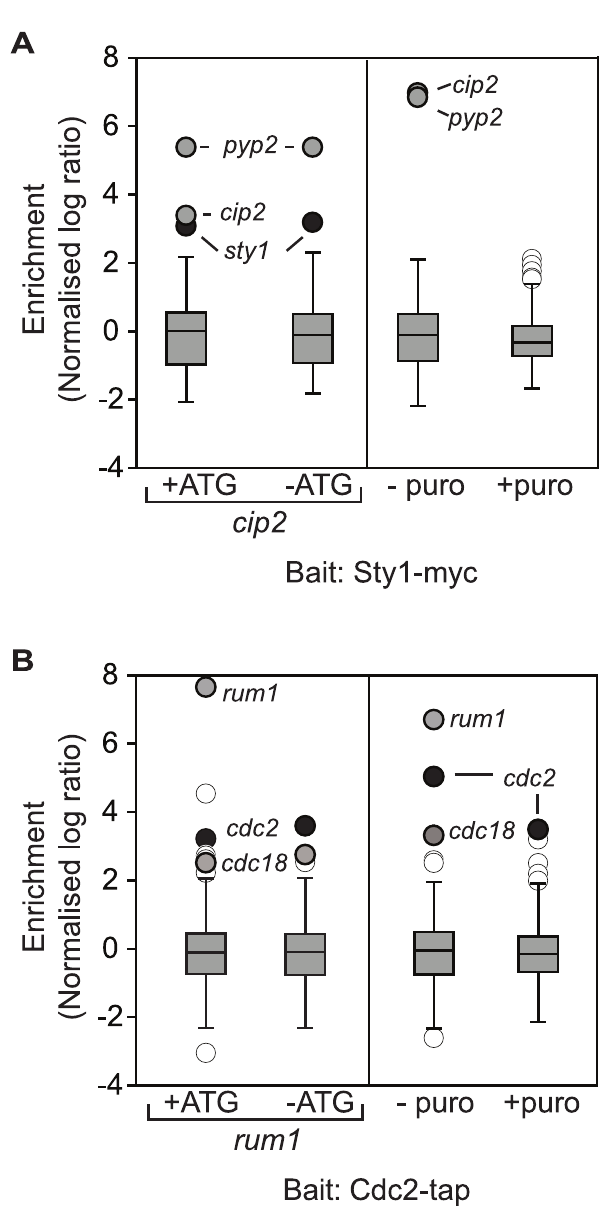
Figure 3. Cotranslational association of Cdc2p-Rum1p and Sty1p-Cip2p. Box plots of the distribution of normalised log 10 enrichments for RIp-chip experiments with (A) Sty1p and (B) Cdc2p (see legend to Figure 1 for details). The left panels show the comparison between 2 ATG cells and the corresponding wild type controls. The right panels display the comparison between cells incubated with puromycin and a mock-treated control. mRNAs encoding the bait are shown in black, mRNAs not considered significant are displayed in white, and other significant mRNAs are presented in grey. presented in Table S3. Integration of constructs at the leu1 locus was performed as described [28].